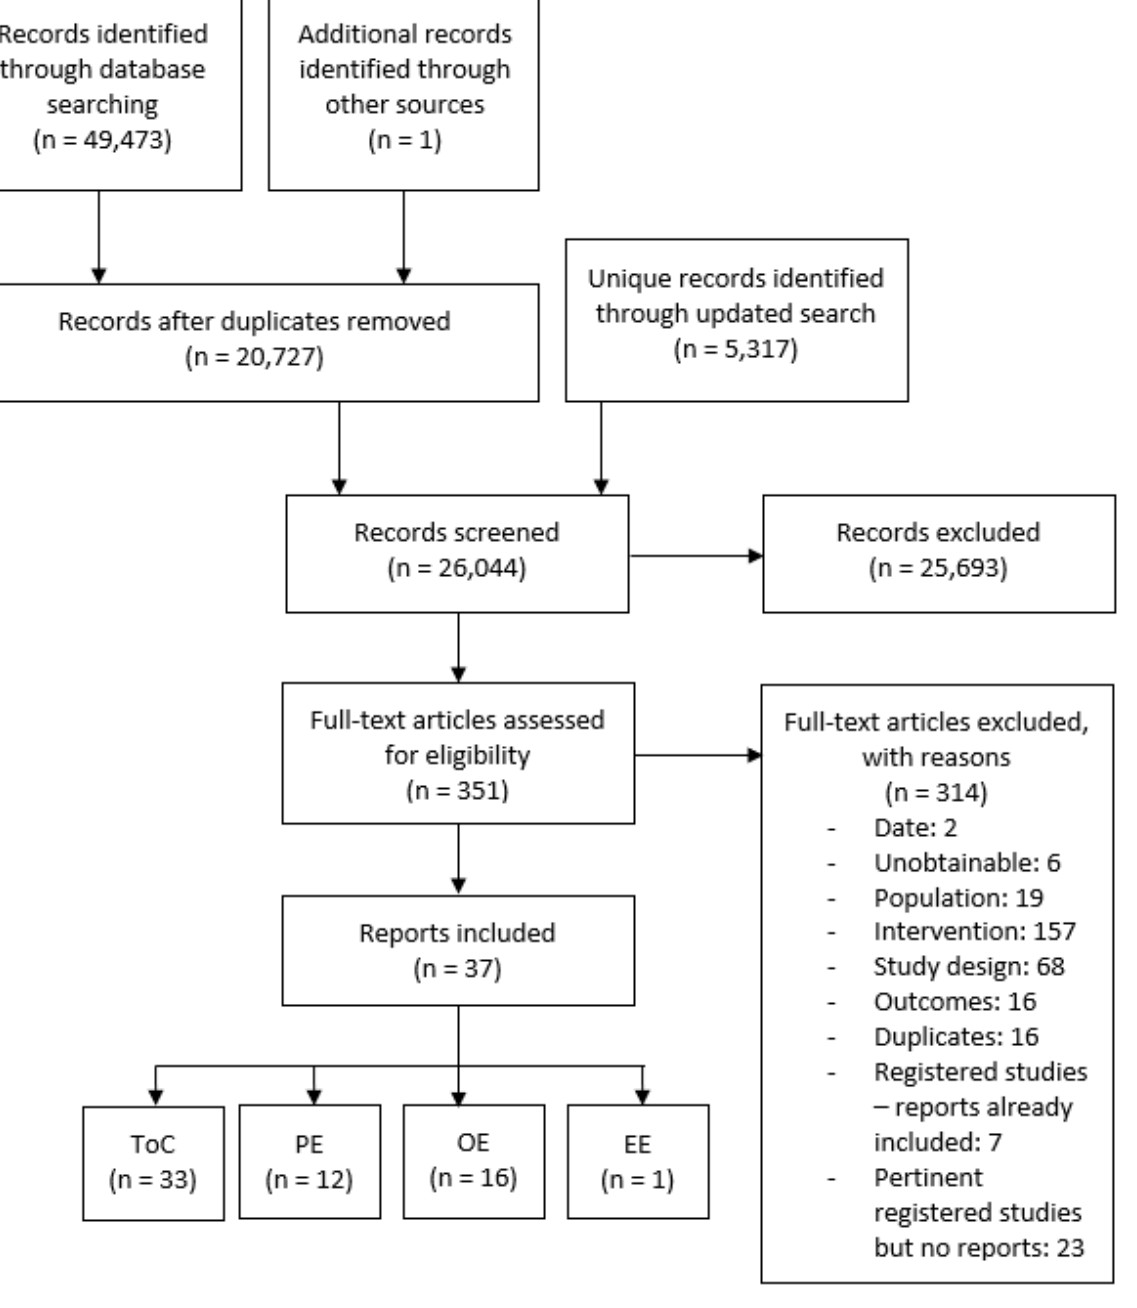
Figure 1. Searches and screening. EE: economic evaluation; OE: outcome evaluation; PE: process evaluation; ToC: theory of